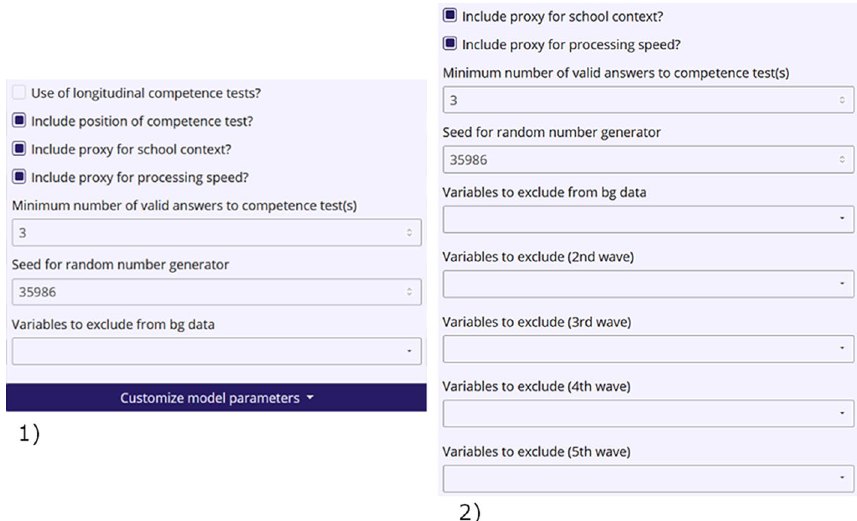
Fig. 4 Further parameters for tweaking the (1) cross-sectional and (2) longitudinal plausible values